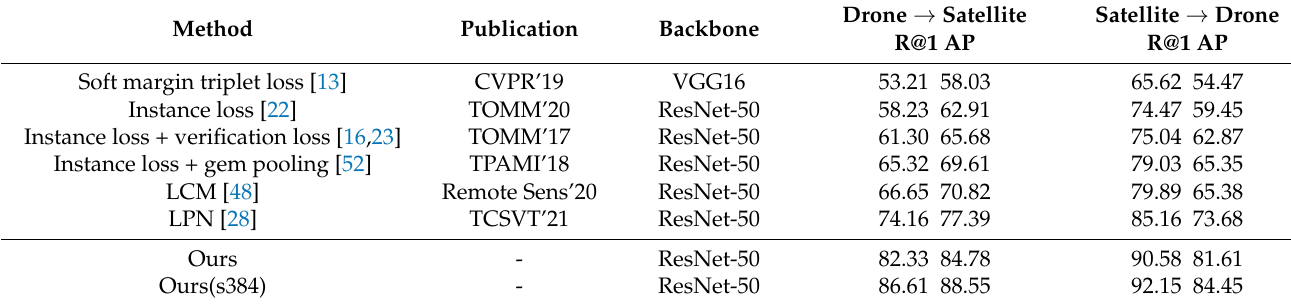
Table 2. Comparison of state-of-the-art results reported on University-1652. s384, input